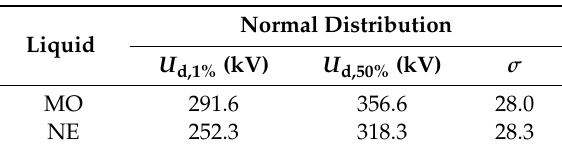
Table 2. Breakdown results for conductor test at positive polarity, normal distribution fitting for mineral oil (MO) and natural ester liquid (NE).